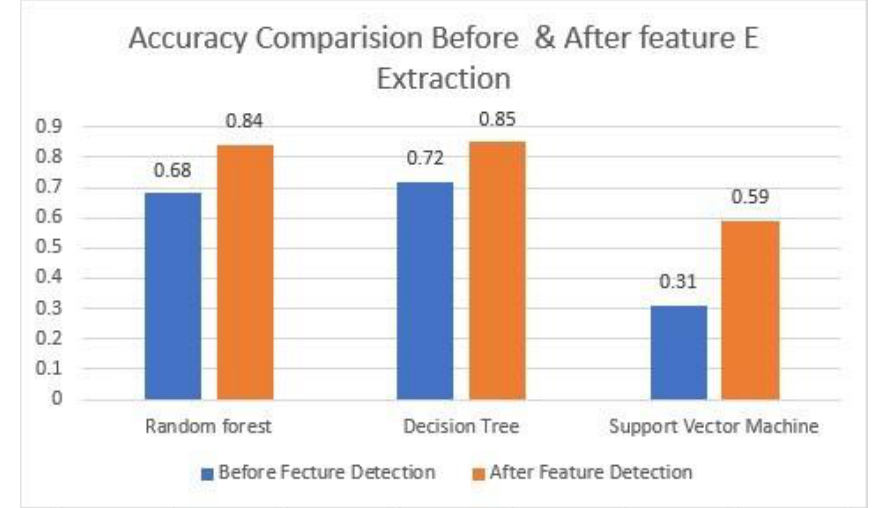
Figure 6. Classifiers accuracy before and after feature extraction.